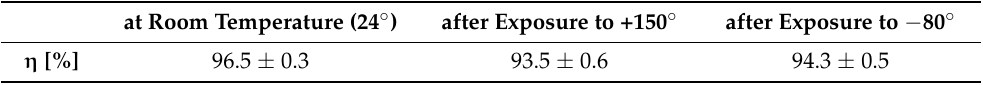
Table 1. Diffraction efficiency measured as a function of